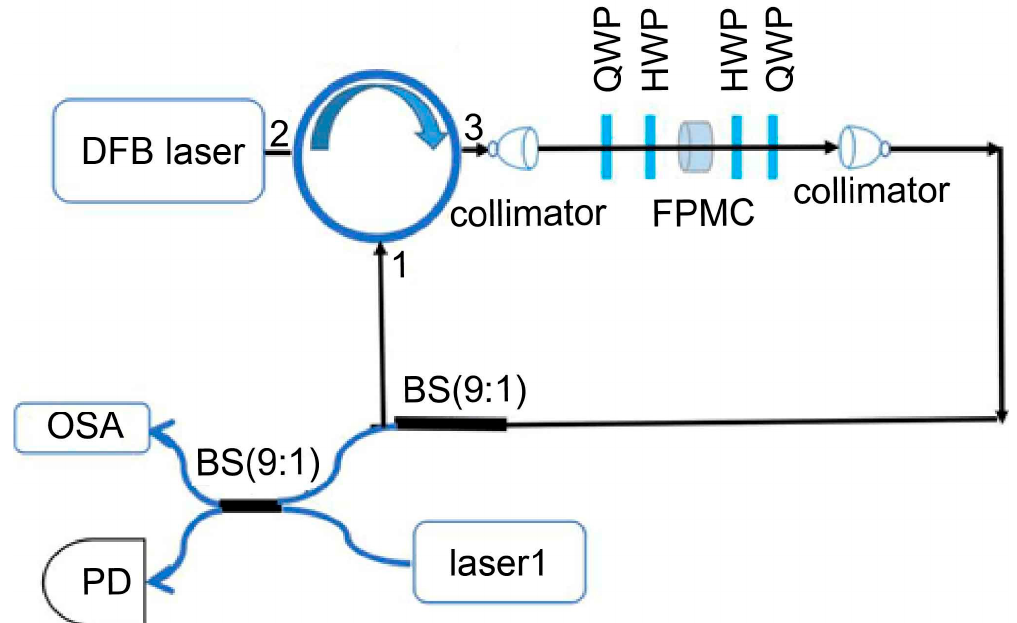
Figure 2. Sketch of experimental setup. FPMC, Fabry-Perot microcavity; QWP, quarter-wave plate; HWP, half-wave plate; BS, beam-splitter; PD, photodetector. OSA, optical spectrum analyzer.